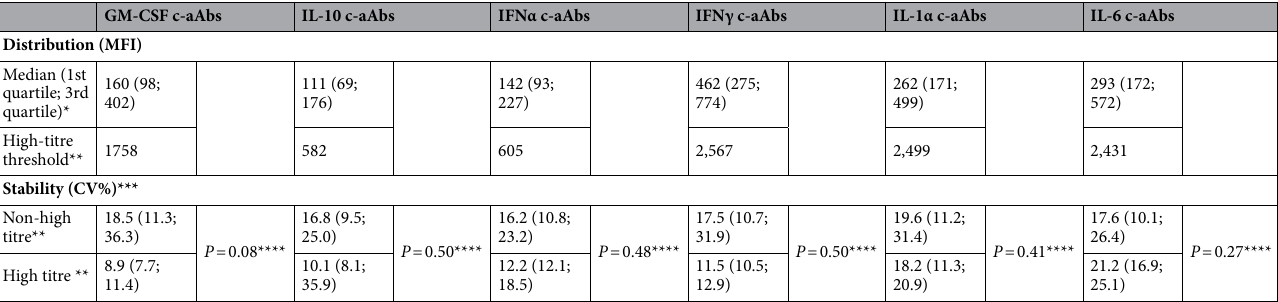
Table 2. c-aAb distribution and stability. *Based on average c-aAb MFI/person. **High titre defined as > 95th percentile MFI cut-off for average c-aAb/person. ***Median (1st quartile; 3rd quartile) for CV% of